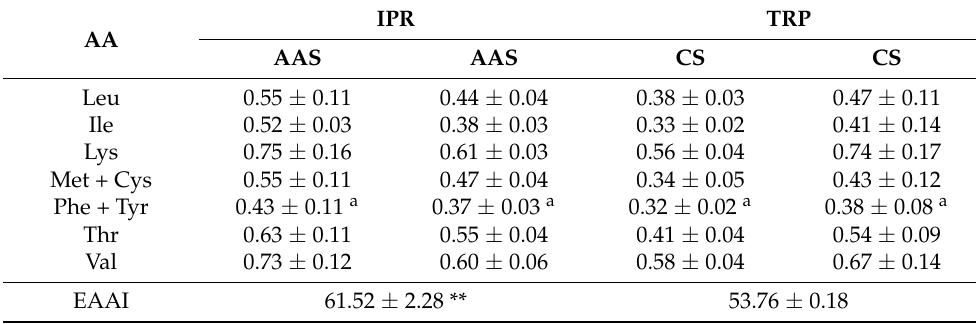
Table 7. AAS, CS and EAAI of muscle of the fish cultured in IPR and TRP.